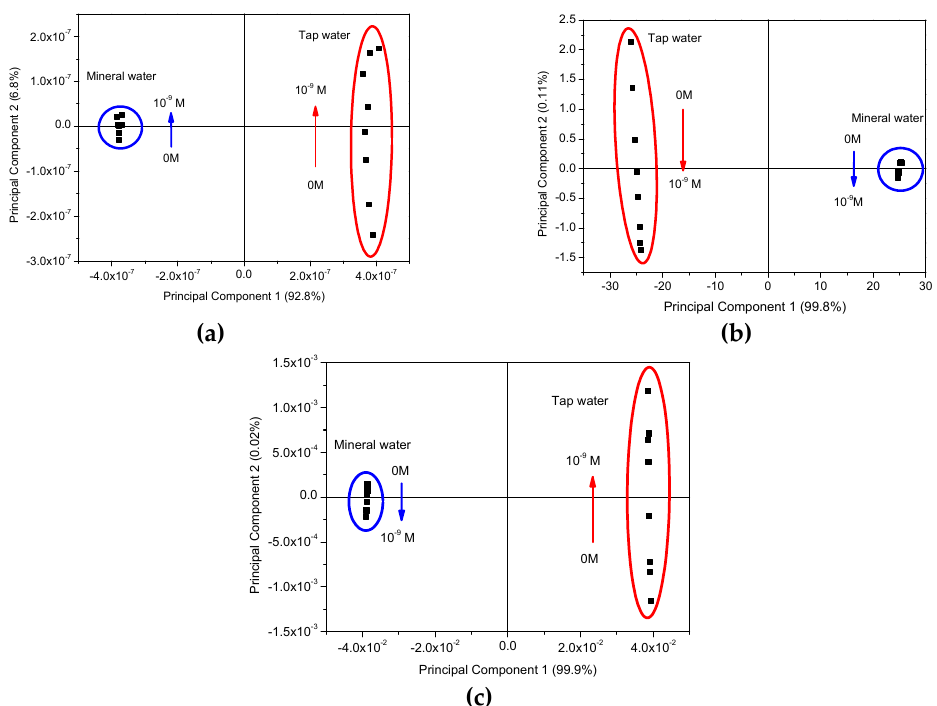
Figure 6. PCA plots using the capacitance ( a ), loss tangent ( b ) and ( c ) electric modulus spectra measured when both uncoated IDE and coated IDE with (PEI/PSS) 5 film are immersed in spiked solutions with EE2 concentrations (10 -9 M to 0 M) prepared with) mineral water and tap water. The colored circular and oval lines surround the PCA achieved data associated with the different waters.